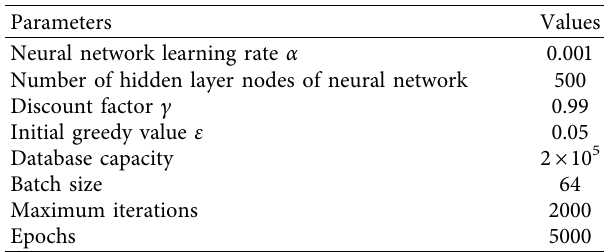
Table 2: Performance comparison with single target point.